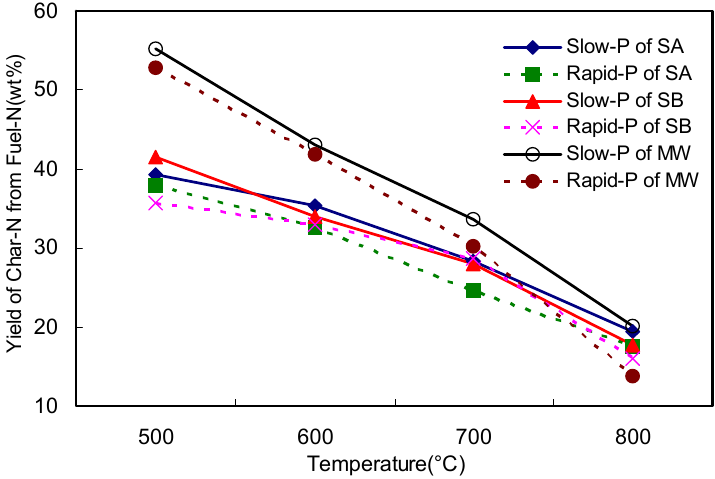
Figure 3. Yield of Char-N after a series of